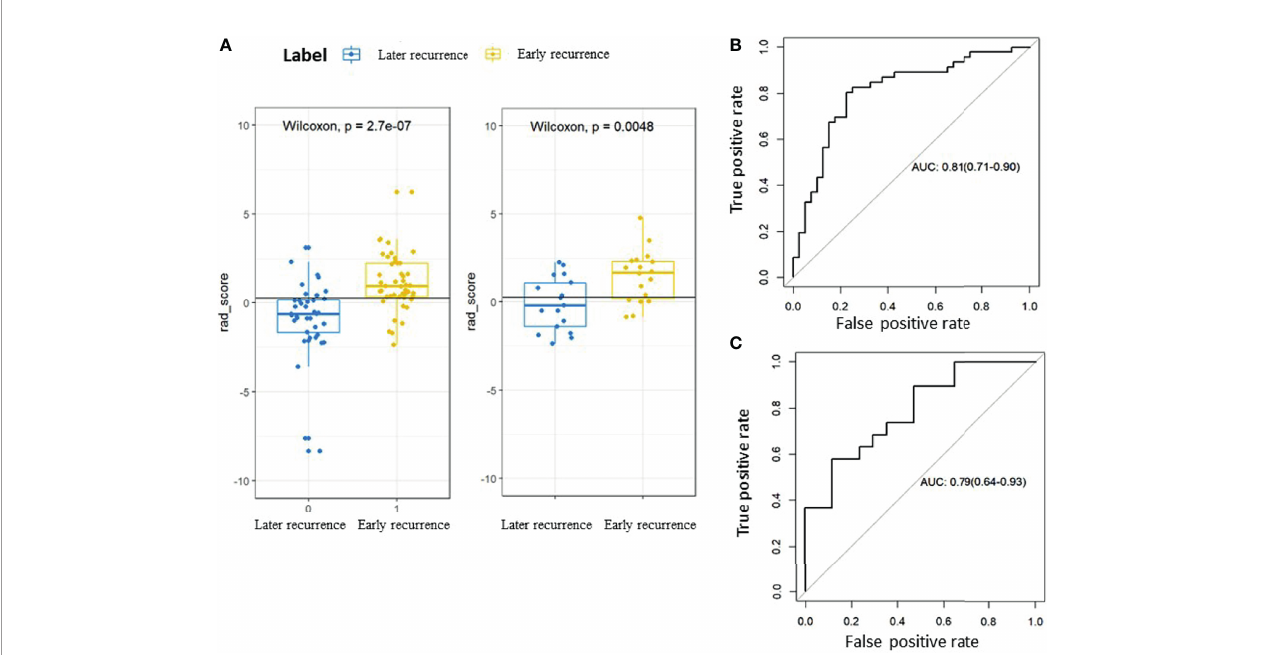
FIGURE 3 | Rad-scores and receiver-operating characteristic (ROC) curves for the early recurrence group and the later recurrence group. (A) Box plots showing the Rad-scores for the early recurrence group and the later recurrence group. The label 0 indicates the later recurrence group and 1 indicates the early recurrence group. The left panel shows the training cohort and the right panel shows the validation cohort. (B) ROC curve for the training cohort. (C) ROC curve for the validation